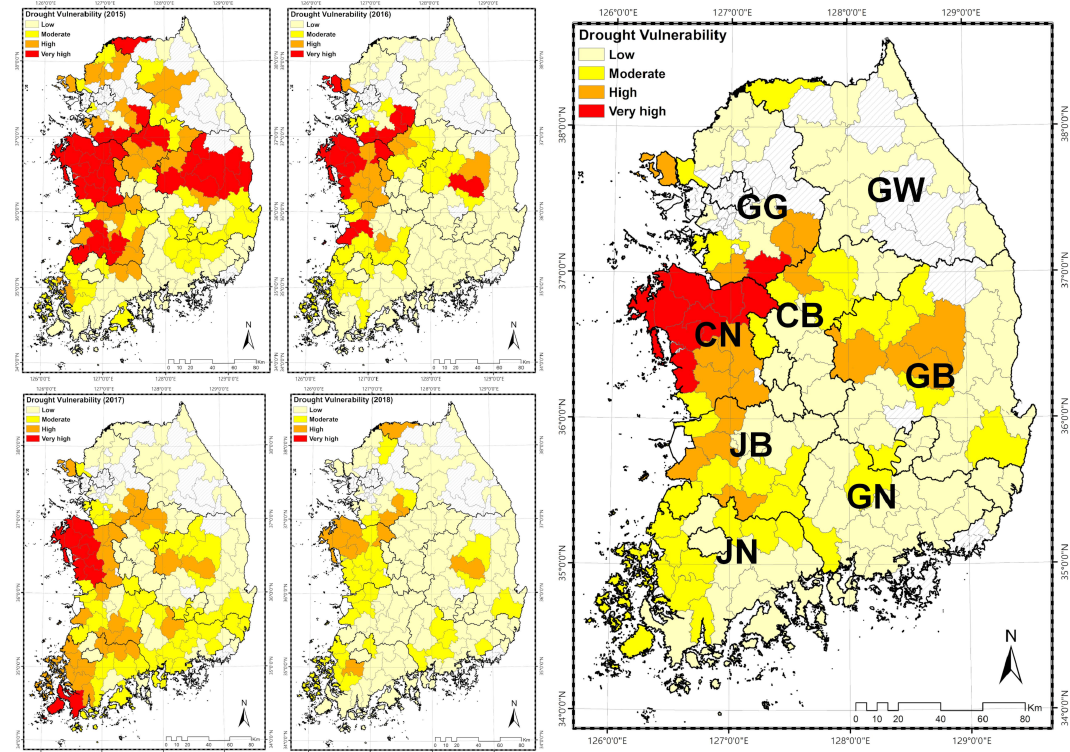
Figure 5. Agricultural drought vulnerability map of South Korea (left: 2015–2018 vulnerability map, right: final vulnerability map).